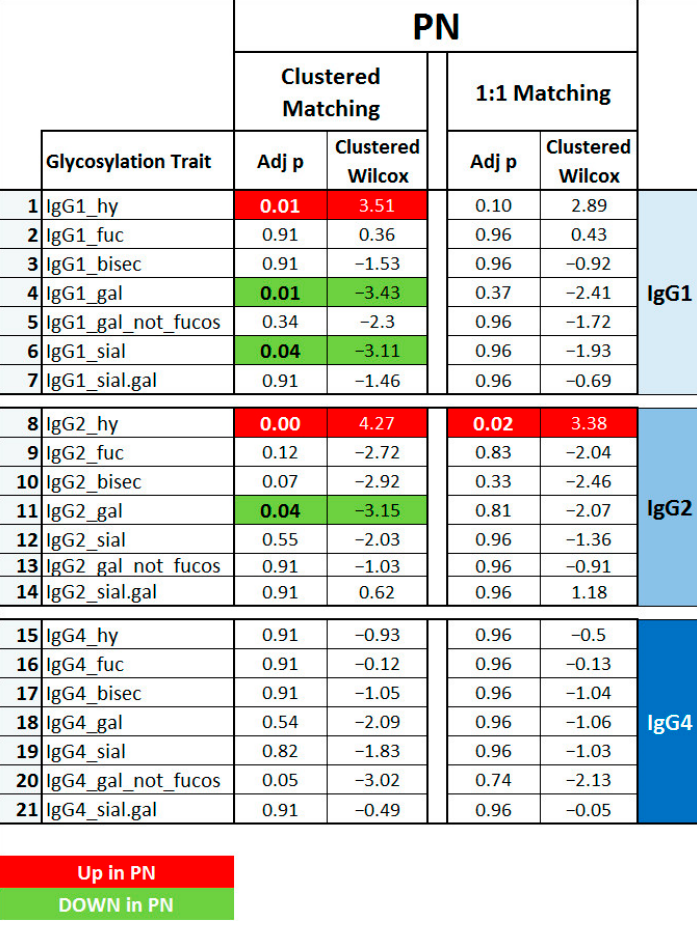
Figure 4. Comparisons between PN patients and matched controls considering the seven glyco- patterns* for each IgG subclass (1, 2 and 4). Matching was performed using a clustered or one-to-one approach. Green and bold indicate significant ( p < 0.05) lower levels in PN patients, while red and bold refers to significant ( p < 0.05) higher levels PN patients (clustered Wilcox). * hy = hybrid glycoforms; fuc = with fucosylation; bisec = with bisection; gal = with galactosylation; sial = with sialylation; gal_not fucos = galactosylation of non-fucosylated glycoforms; sial.gal = sialylation per galactose.